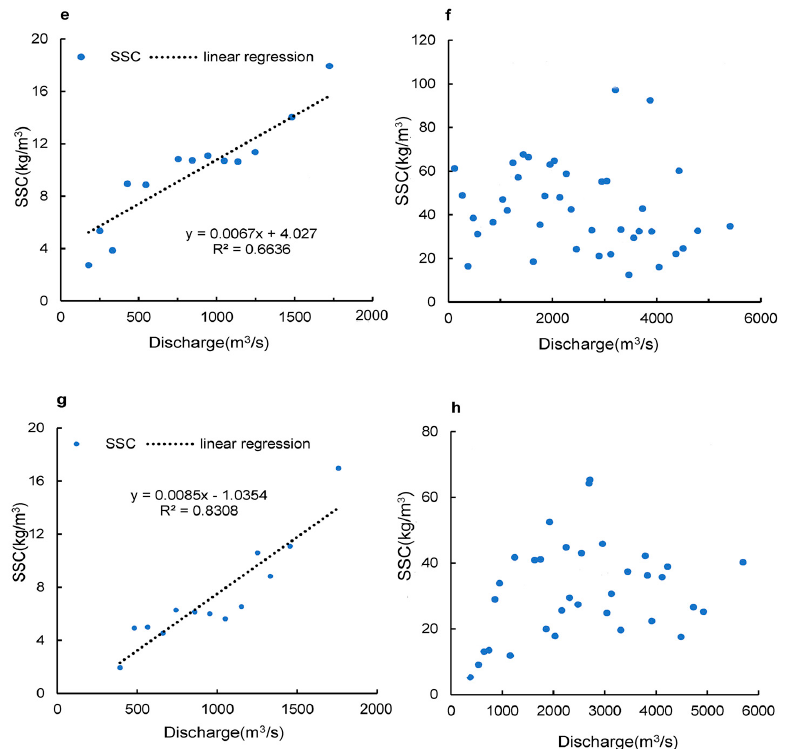
Figure 3. Seasonal rating curves for discharge and SSC in ice - flood seasons at ( a ) Toudaoguai, ( c ) Longmen, ( e ) Tongguan, ( g ) Huayuankou stations and in rainy seasons at ( b ) Toudaoguai, ( d ) Longmen, ( f ) Tongguan, ( h ) Huayuankou stations from 1960 to 2015.